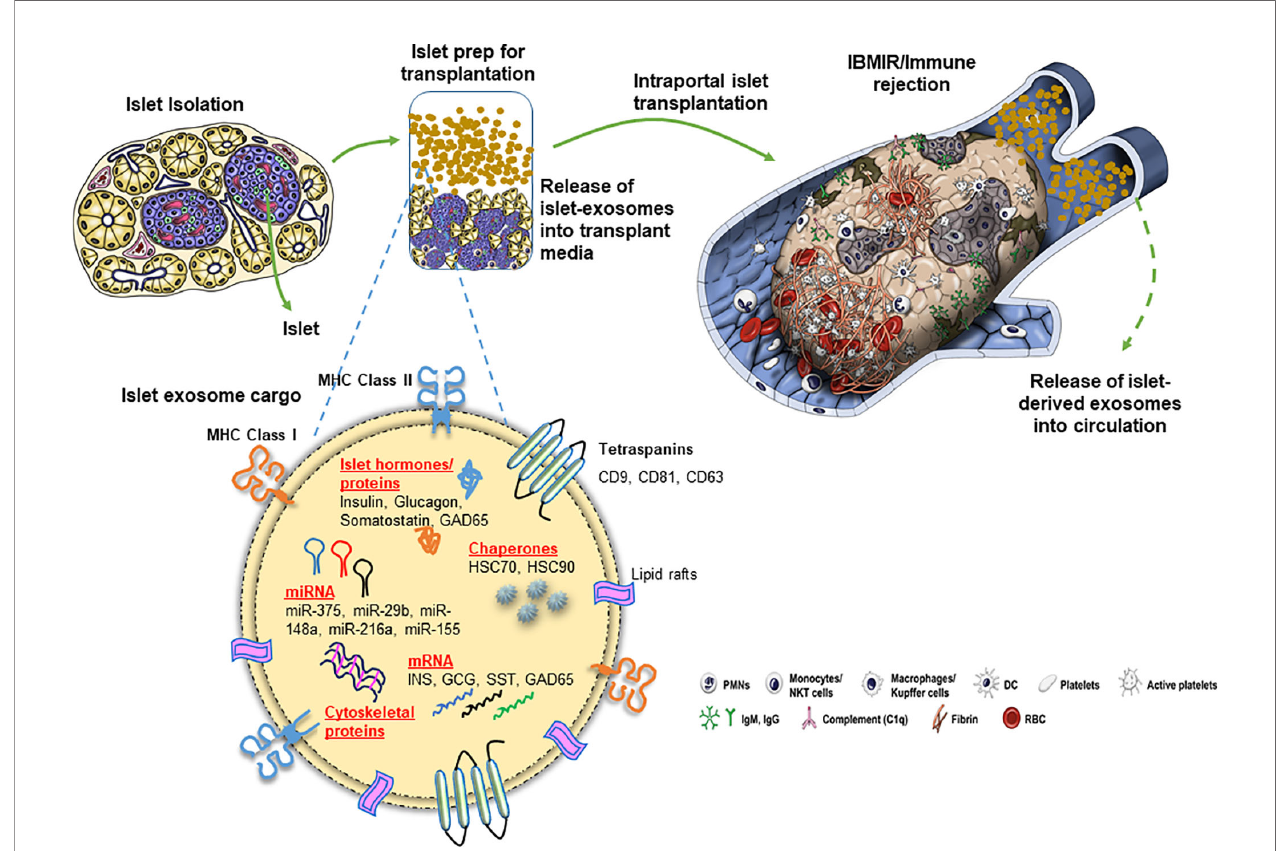
FIGURE 1 | Release of exosomes and their cargo from human pancreatic islets during clinical islet transplantation.